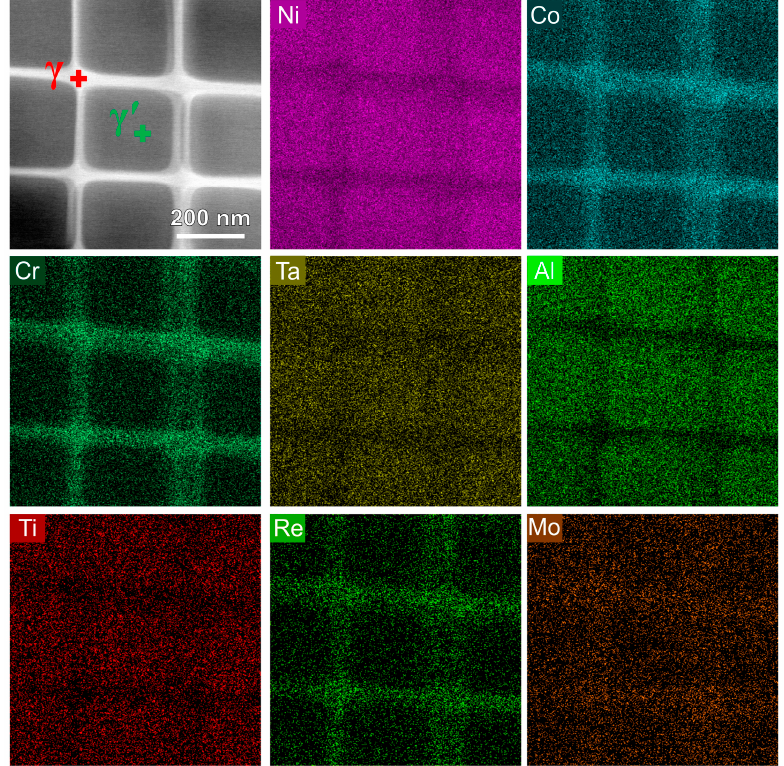
Figure 9. TEM-EDS maps showing the elemental distribution in γ and γ′ phases of the 3Ta6.4Al1Ti alloy.